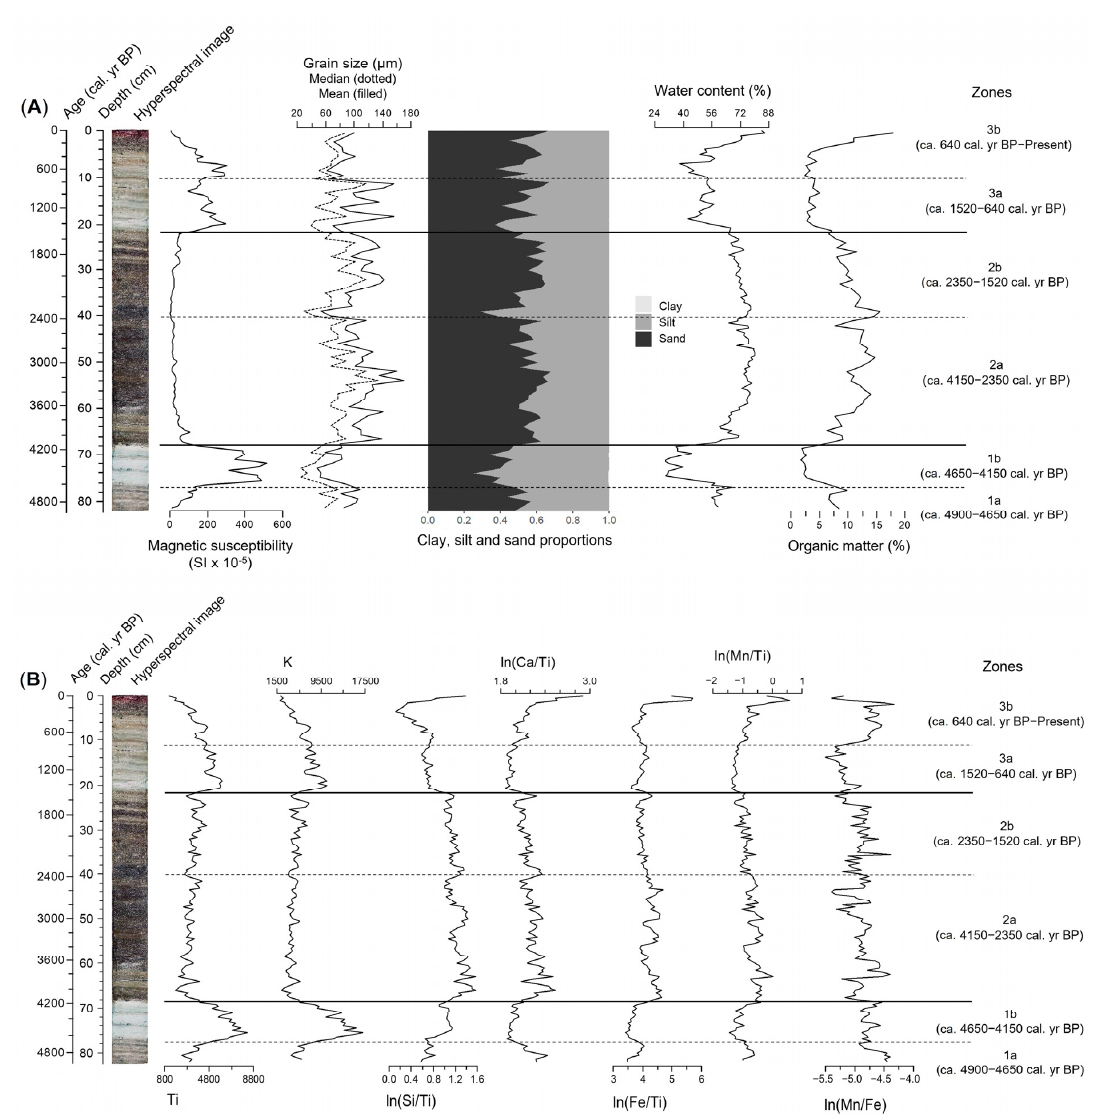
Figure 3. ( A ) Oakes Bay West Lake core litho-sedimentological profiles and significant stratigraphic zones (CONISS); ( B ) geochemical profiles ( µ -XRF) of the Oakes Bay West Lake core and significant stratigraphic zones (CONISS). The two main events are identi fi ed by sub-Zones 1b and 3a.